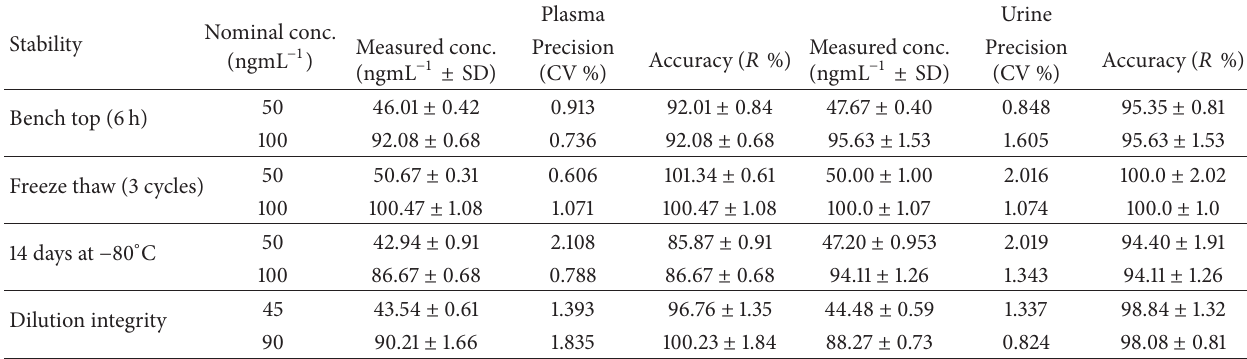
Table 5: Stability and dilution integrity data of PTB.